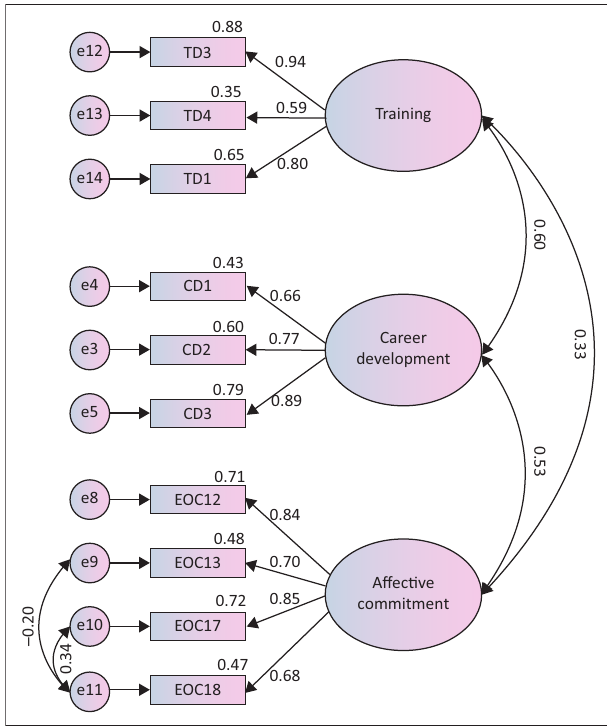
FIGURE 2: The measurement model.